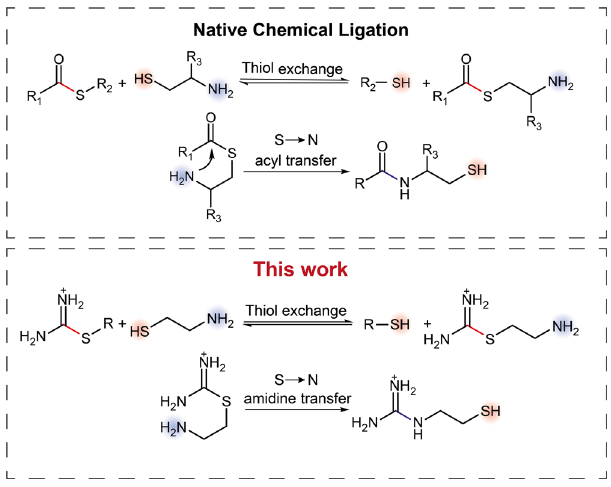
Fig. 1 The analogy between native chemical ligation and the thiol- assisted formation of guanidines from thiouronium salts. The top panel shows the mechanism of native chemical ligation. The bottom panel shows a proposed mechanism for the thiol-assisted formation of